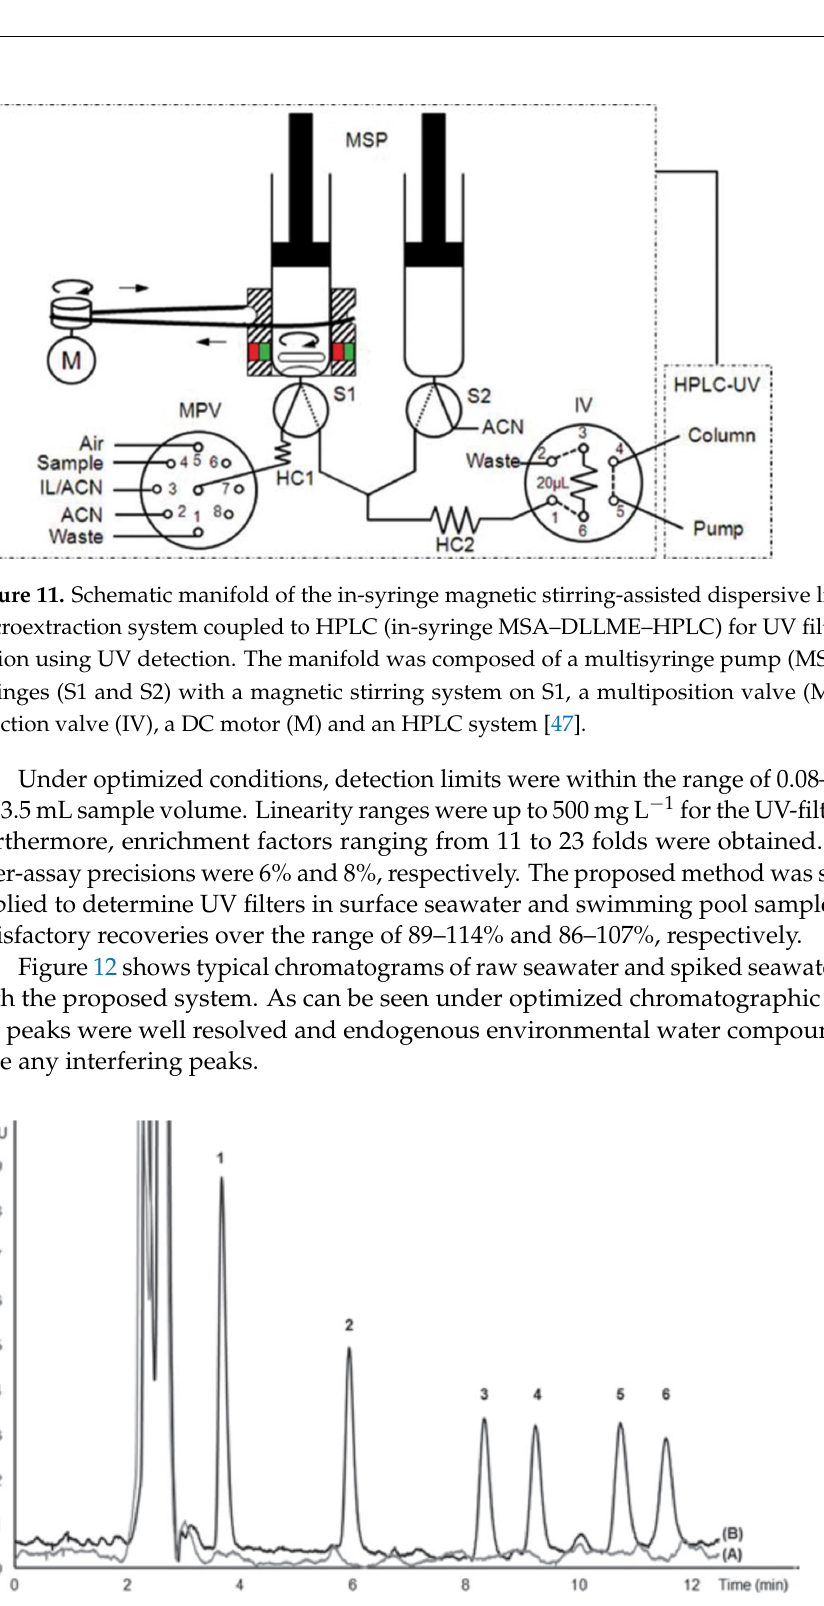
Figure 12. Chromatogram of UV filters analyzed with the proposed in ‐ syringe MSA ‐ DLLME ‐ HPLC system: (A) surface seawater and (B) spiked surface seawater with 25 mg L − 1 2 ‐ Hydroxy ‐ 4 ‐ methoxybenzophenone (1), 10 mg L − 1 3 ‐ (4 methylbenzylidene) camphor (2), 25 mg L − 1 cyano ‐ 3,3 ‐ diphenylacrylate (3), 10 mg L − 1 2 ‐ ethylhexyl 4 ‐ dimethylaminobenzoate (4), 60 mg L − 1 ethylhexyl salicylate (5), 60 mg L − 1 homosalate (6) [47].